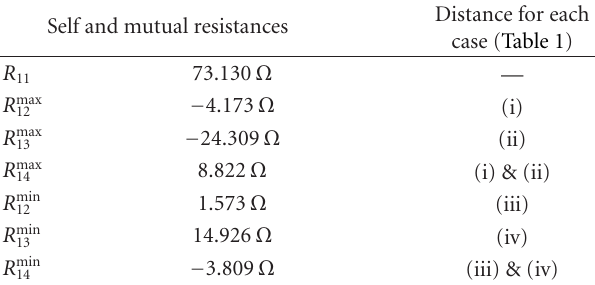
Table 4: Self and mutual resistances of half-wavelength dipole antennas.